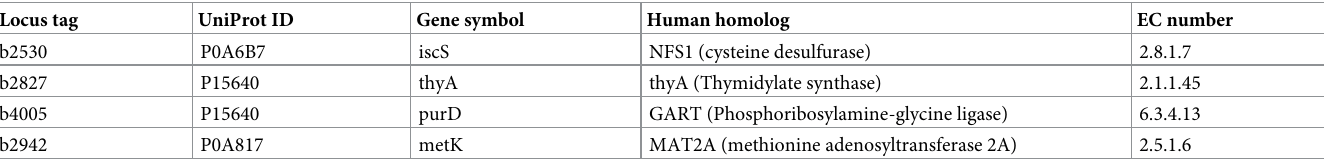
Table 2. Essential genes with human